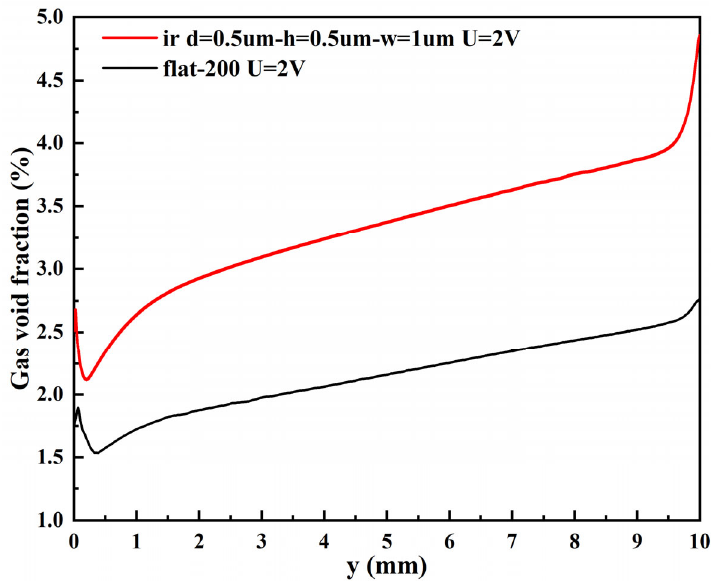
Figure 11. The gas void fraction curves of the micro-nano surface and vertical flat electrodes under the same voltage (U = 2 V).